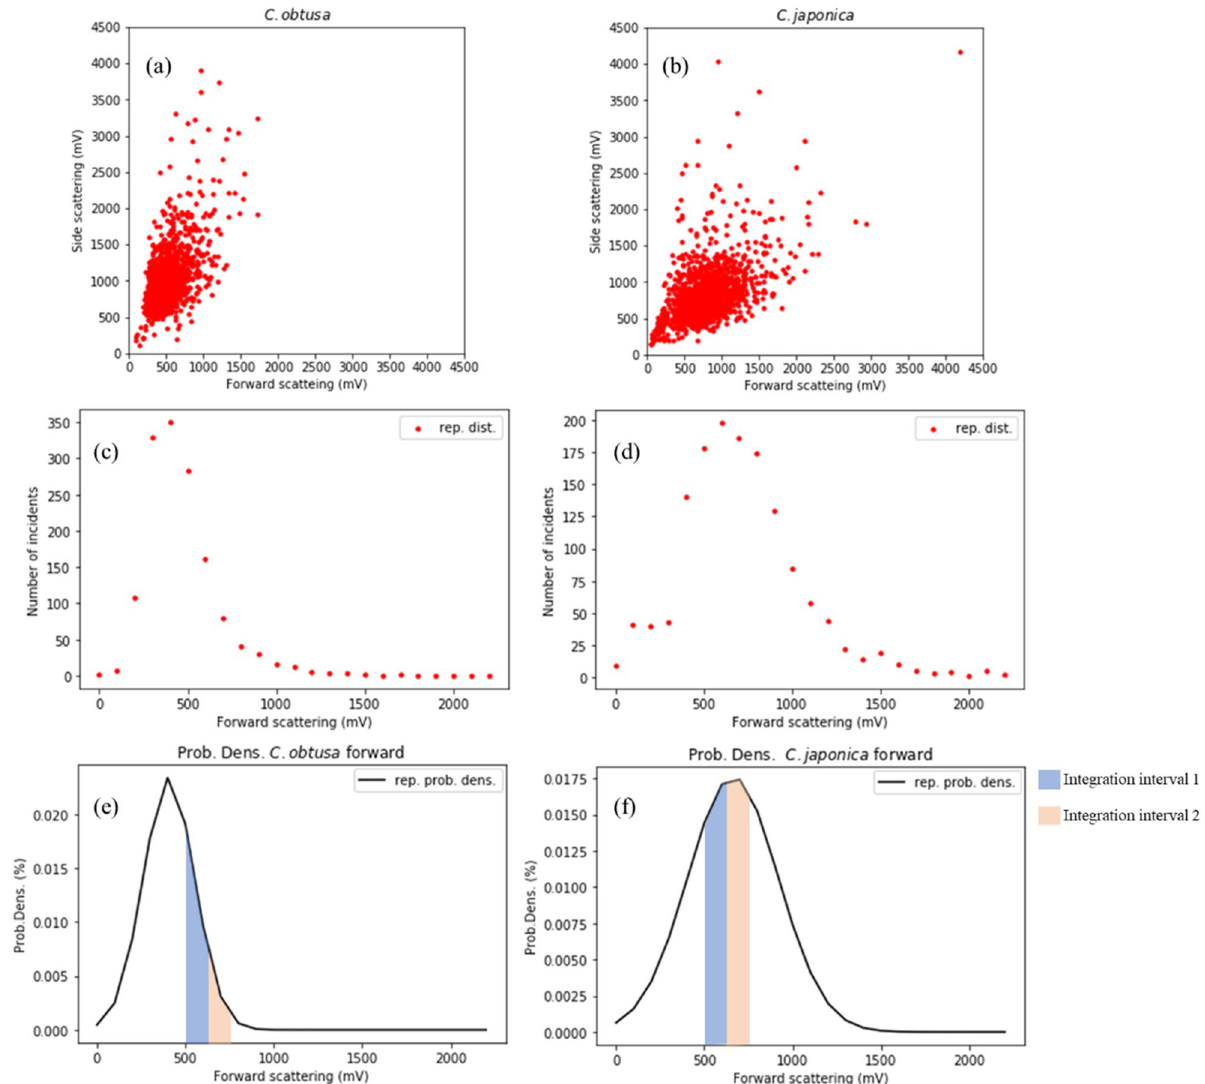
Figure 4. ( a ) Scattering intensity of Chamaecyparis obtusa and ( b ) Cryptomeria japonica , ( c ) number of forward-scattering signals of C. obtusa and ( d ) C. japonica , ( e ) probability density of forward-scattering signals of C. obtusa and ( f ) C.